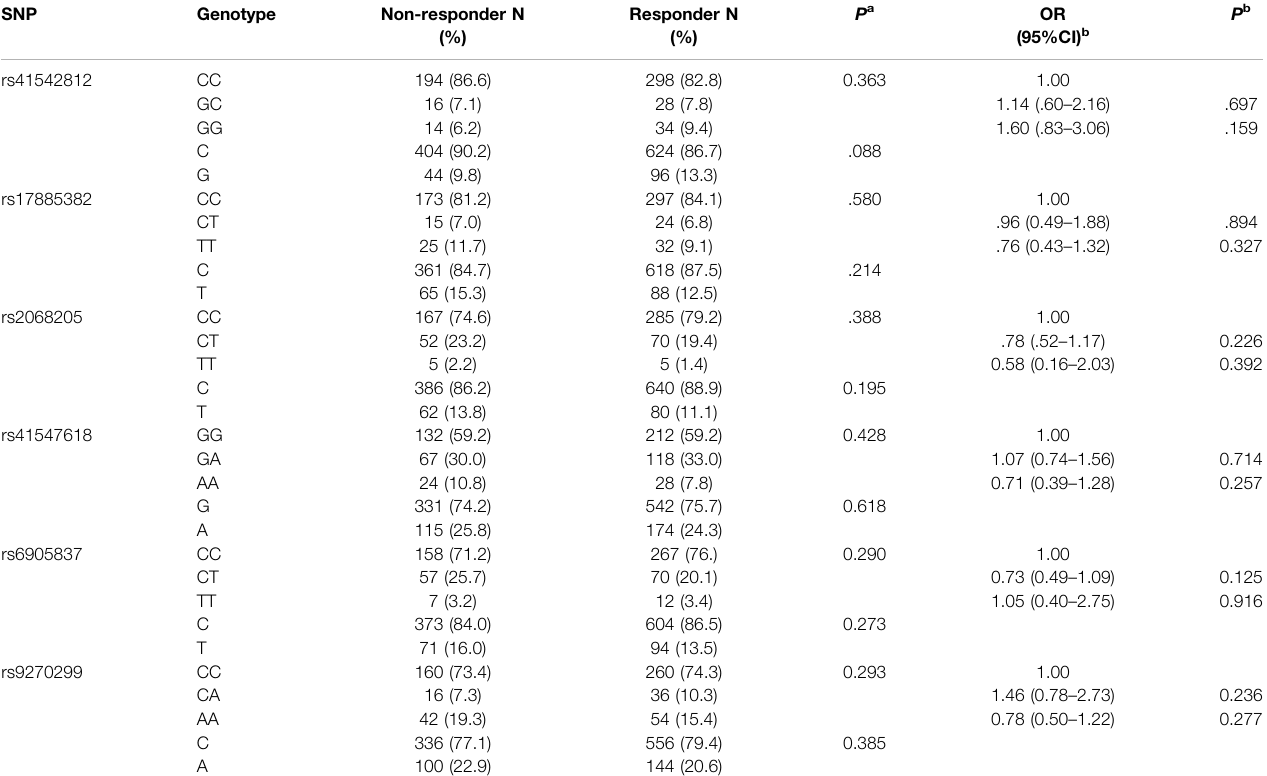
TABLE 2 | HLA SNPs genotype frequencies in responder and non-responder groups.